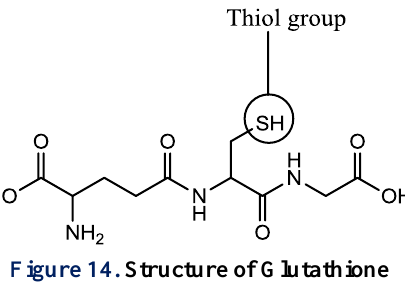
Figure 14. Structure of Glutathione